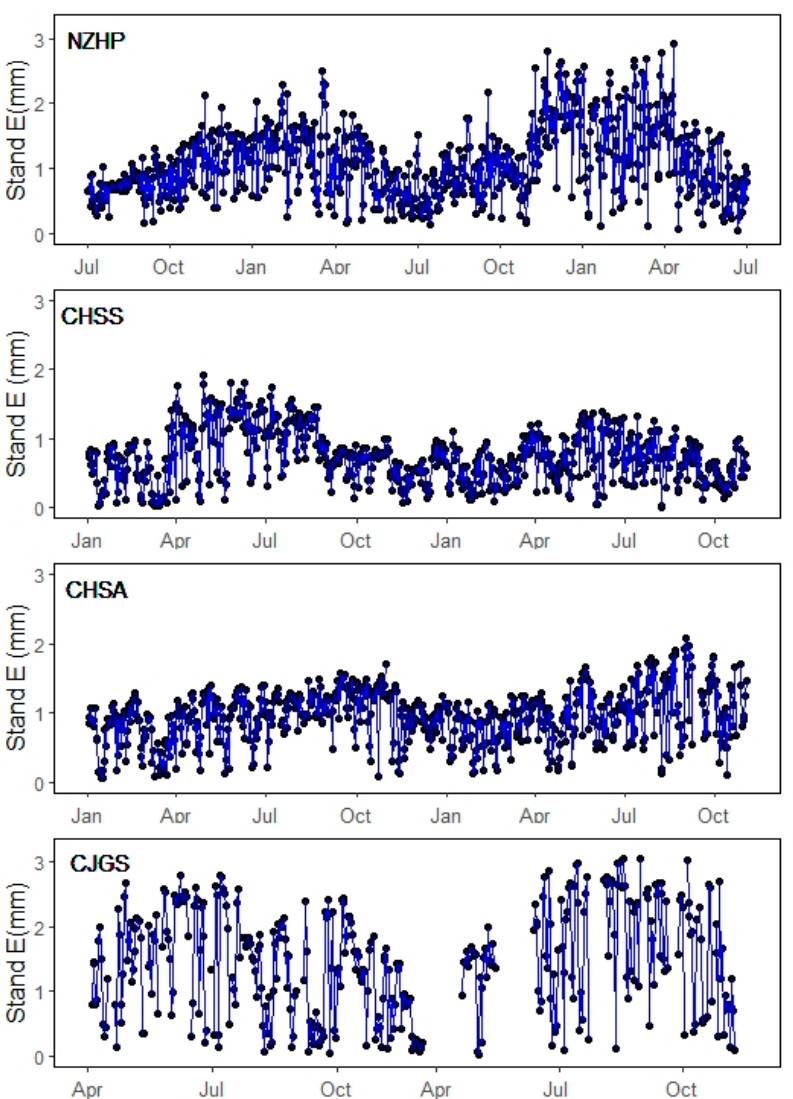
Figure 5. Daily stand scale transpiration of four research sites during the study period. Principle components analysis (PCA) on all our research sites showed that the first three factors explained 78%–86% of the total variation in tree transpiration based on local environmental variables across three climatic zones (Table 4). The first component (PC1) explained 38%–53% of the variance and was positively correlated with temperature, PAR and VPD and negatively correlated to rain and RH or soil moisture, suggesting that high evaporative demand with dry, sunny and warm climatic conditions would cause a strong atmosphere-canopy reaction [8]. The second and third component explained between 13% and 26% of the total variance in the dataset and were related to precipitation and wind, as well as soil